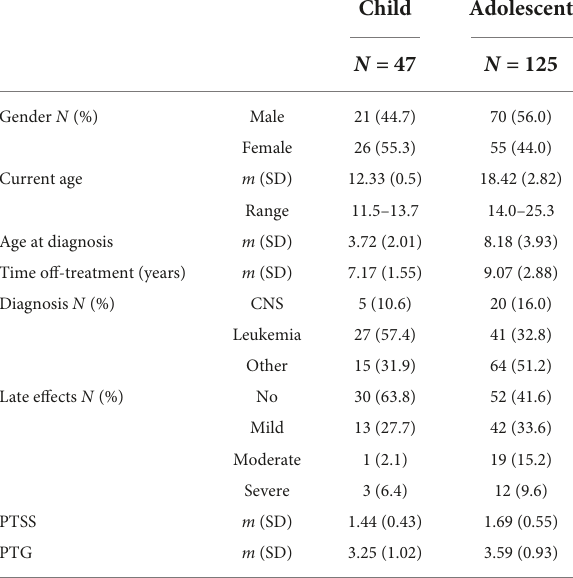
TABLE 1 Sample characteristics for child and adolescent